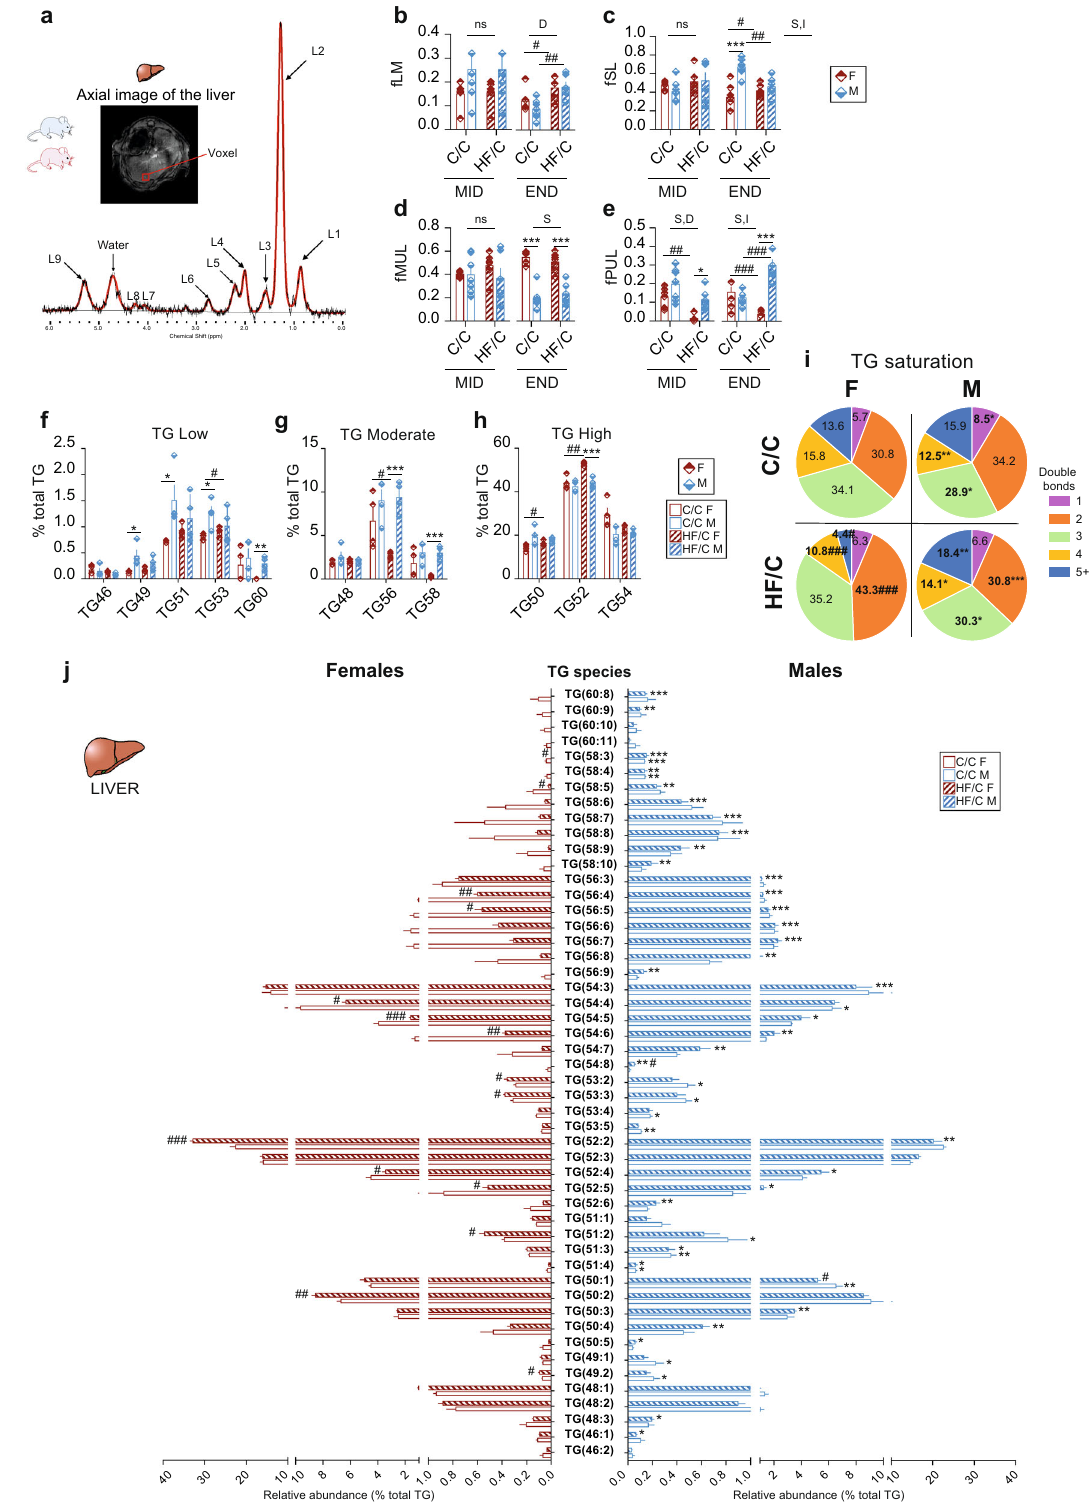
liver contained more of the very-long chain TG species when compared to F. In contrast, HF/C F exhibited higher relative content of the shorter TG species. In conclusion, MO